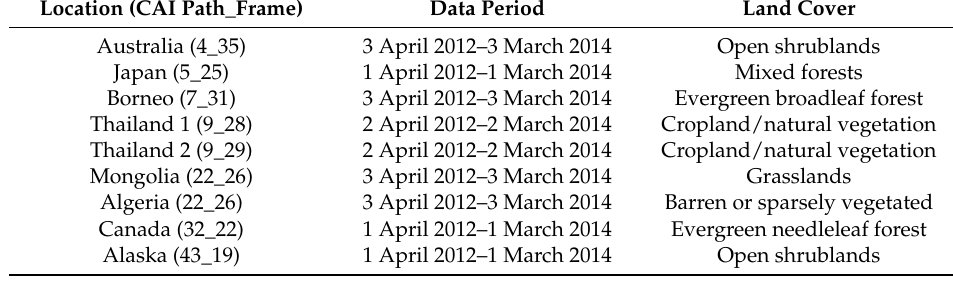
Table 2. GOSAT CAI L1B products evaluated in this study. Land-cover was derived from the MODIS land cover type product (MCD12).